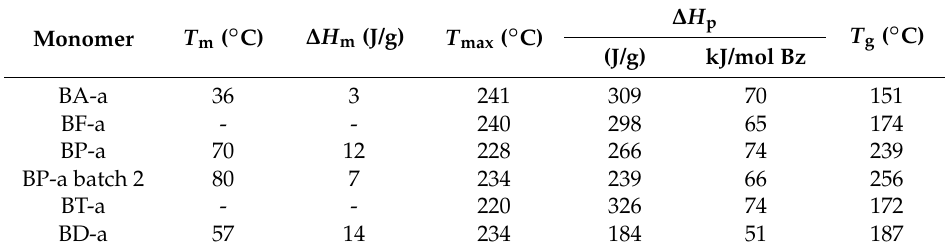
Table 1. DSC First Heat Data of Monomers (20 to 300 ◦ C at 10 K/min).